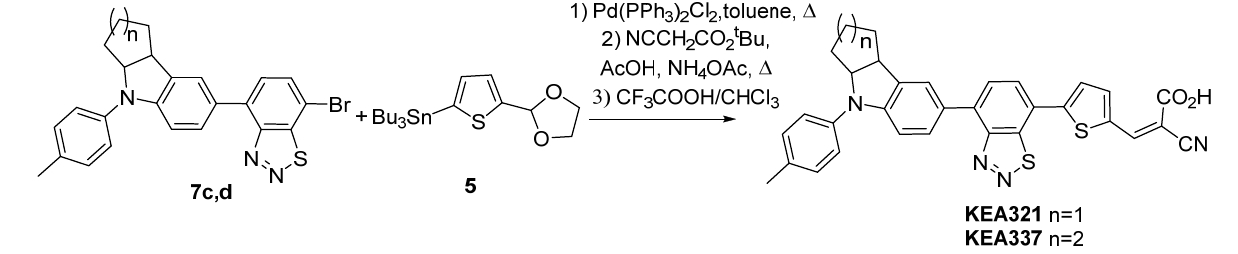
Figure 2. The general view of compounds 7b , 8b , 7e and 7f in representation of atoms by thermal ellipsoids ( p = 50%).